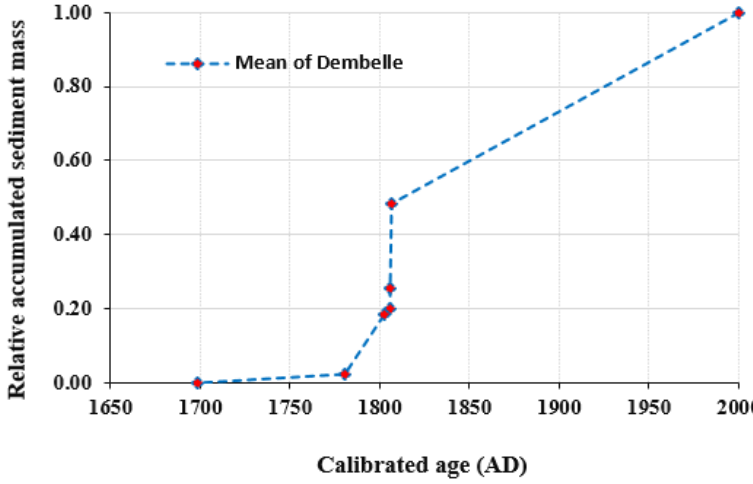
Figure 17. Age and average relative accumulated sediment mass for the different corings in the Dembelle floodplain deposits .